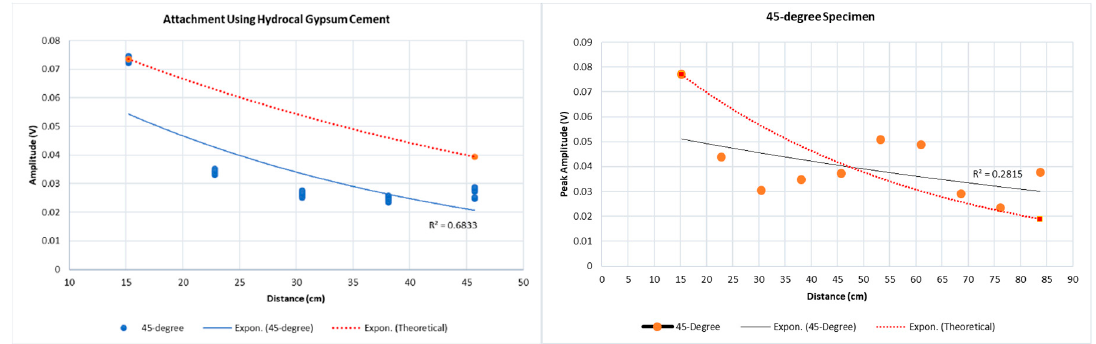
Figure 19. Left: Measurements from the cored 45 degree specimen with transmitter attached perpendicularly to the bar with Hydrocal gypsum (as shown in Figure 18). Right: Measurements from the 45 degree specimen with transmitter coupled with WLG at a 45 degree angle to the longitudinal axis of the rebar from the end.